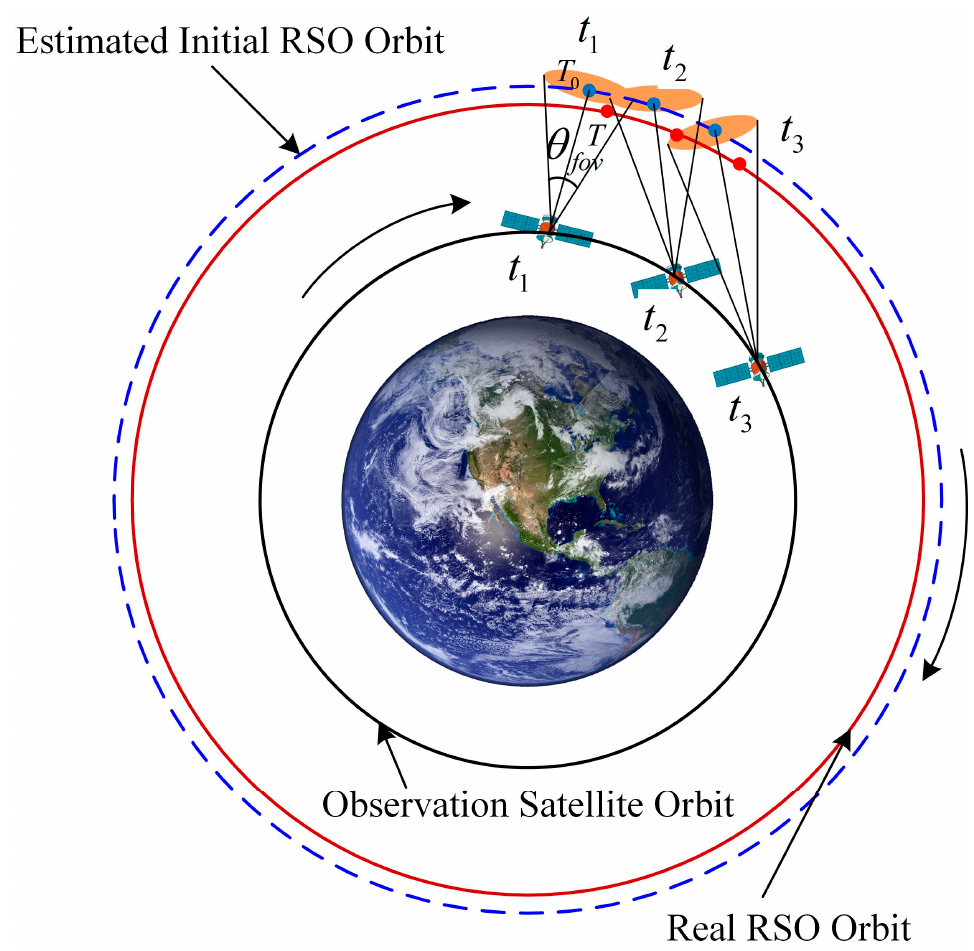
Figure 1. Schematic diagram of tacking imaging in the star tracker.